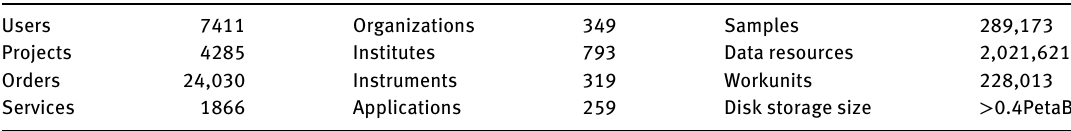
Table 2: Some numbers on system usage as of June 8,